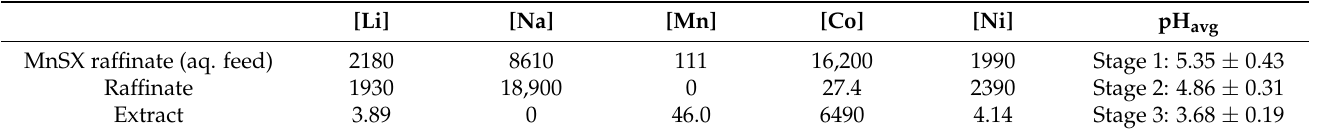
Table 3. Compositions of the extract and raffinate in three-stage countercurrent extraction of Co from the MnSX raffinate by 0.8 M Cyanex 272. S/F = 2.5; T = 21 ± 1 ◦ C; τ mix = 5.7 min. Concentrations in [mg L − 1 ]. Numbering of the stages is started from the organic feed